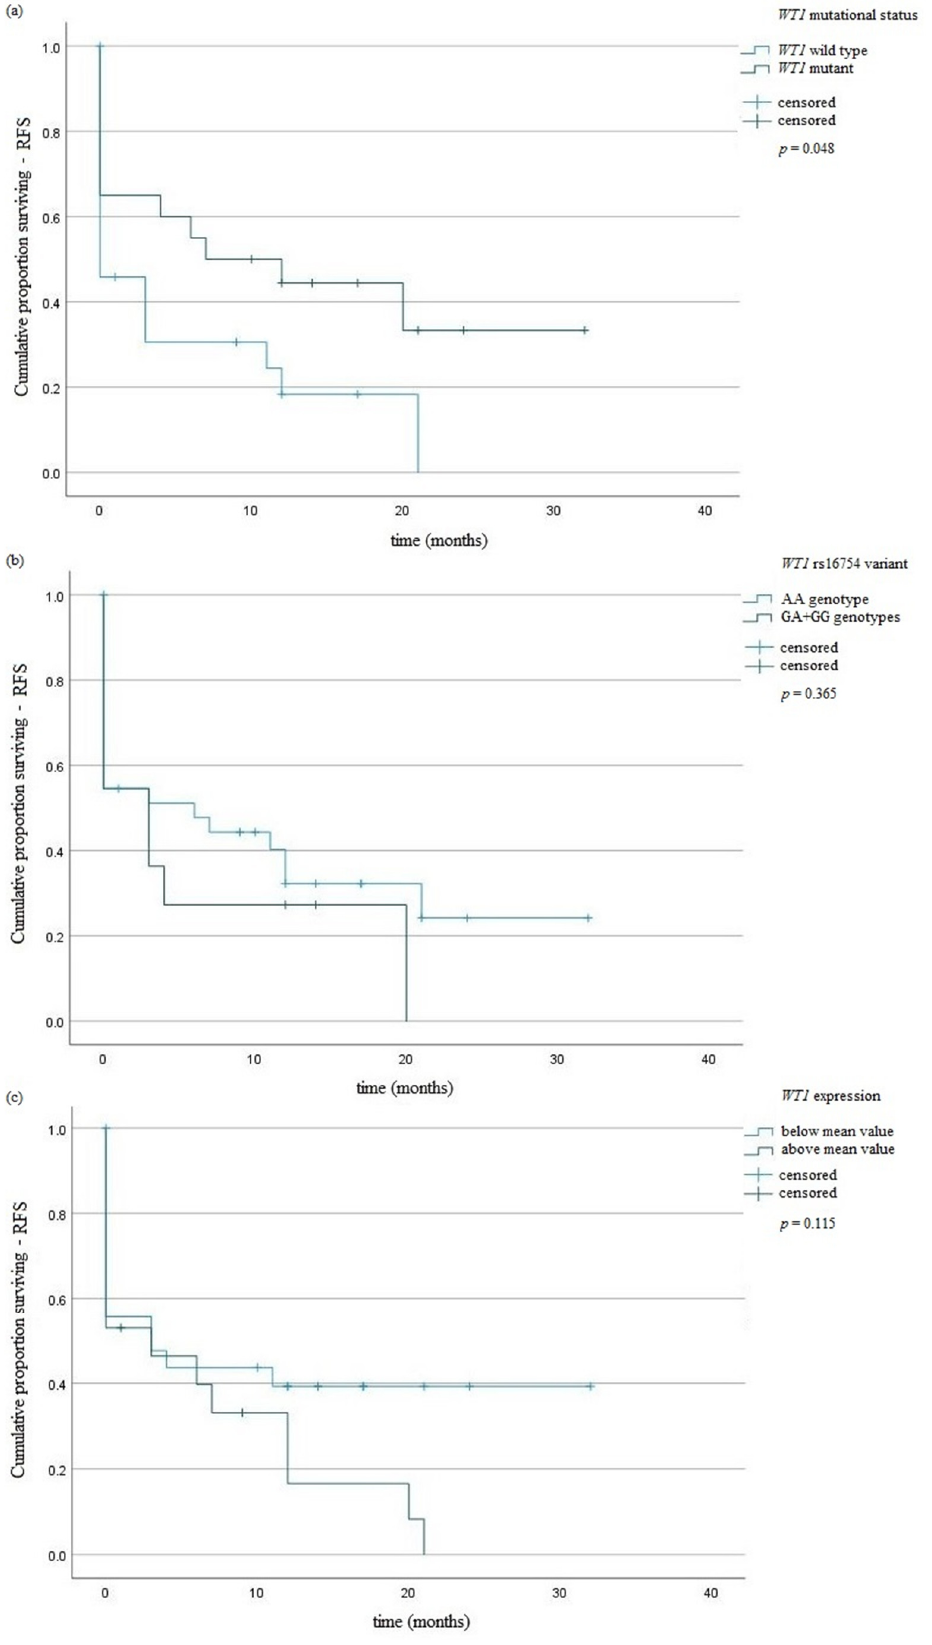
Figure 2. Kaplan–Meier analysis of RFS in the group of AML patients taking into account: ( a ) WT1 mutation; ( b ) WT1 rs16754 variant; ( c ) WT1 overexpression.